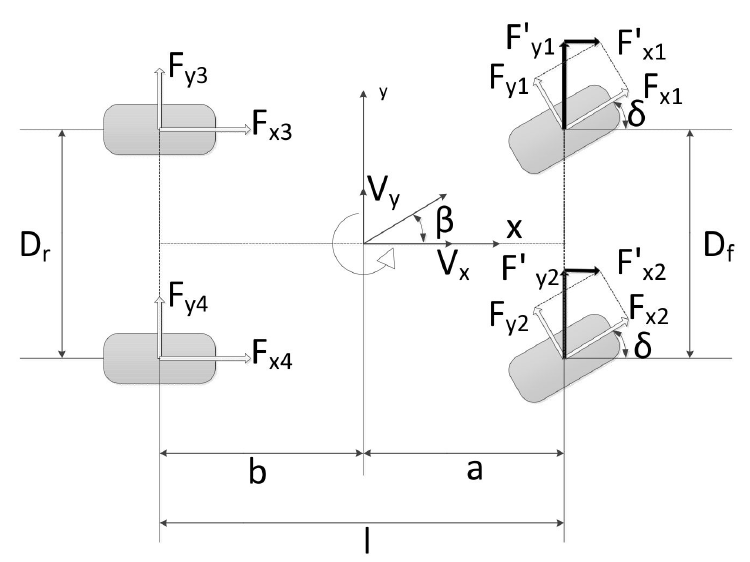
Figure 1. 4WID EV